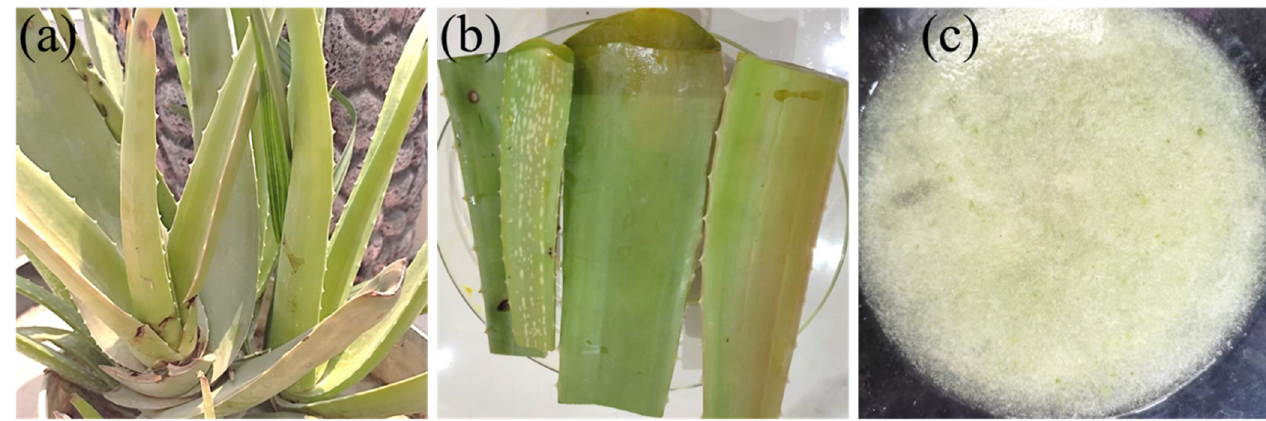
Figure 10. ( a ) Aloe vera plant, Aloe barbadensis , ( b ) washed aloe vera leaves, and ( c ) natural aloe vera